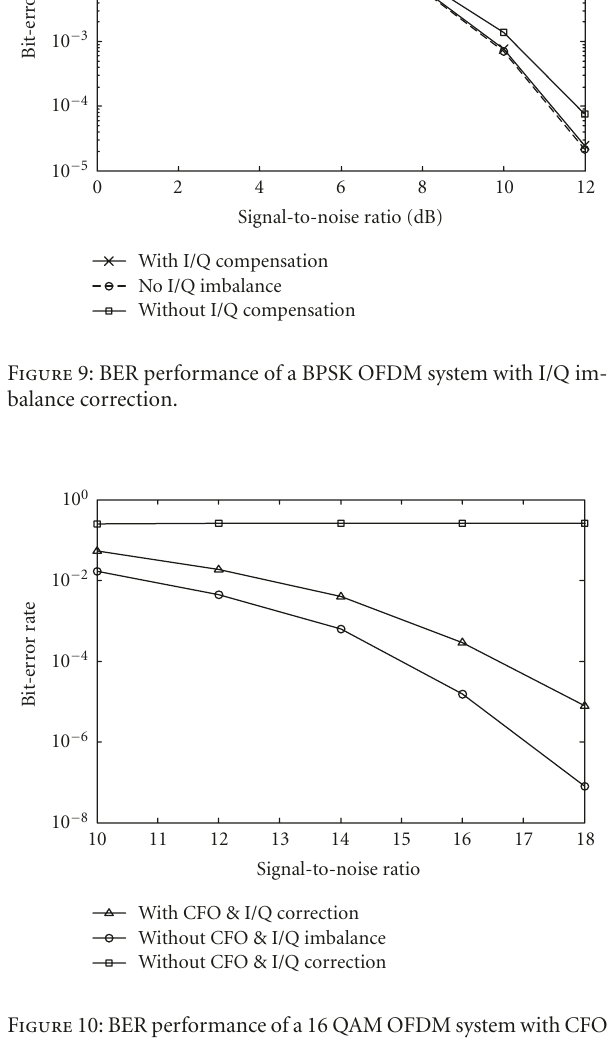
Figure 10: BER performance of a 16 QAM OFDM system with CFO and I/Q imbalance